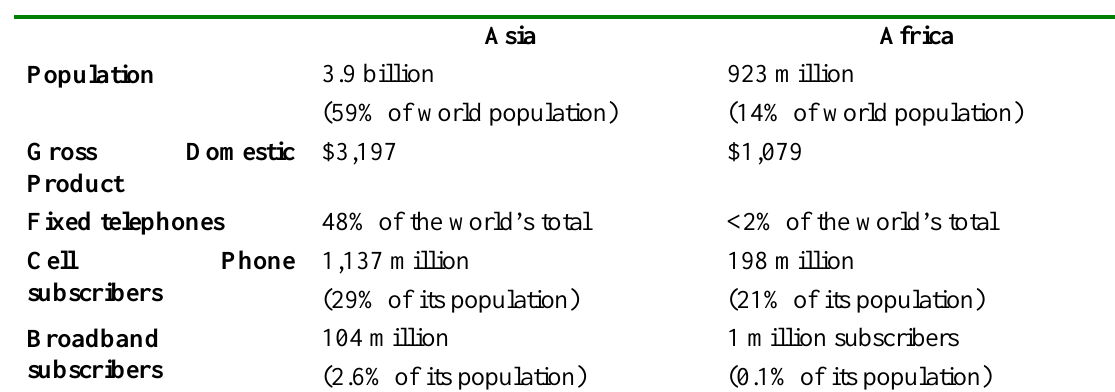
Table 1. Technological usage in Asia and